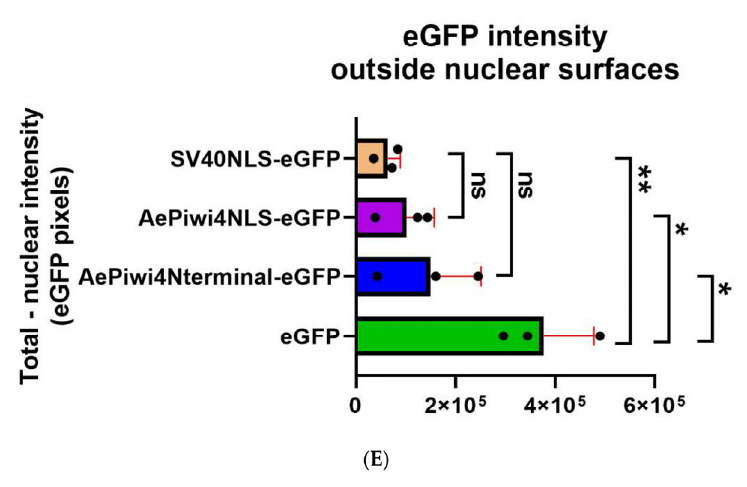
Figure 6. AePiwi4 harbors an NLS in the N-terminal region of the protein. Representative slices from image stacks of HEK293 cells transfected with ( A ) SV40NLS-eGFP, ( B ) eGFP, ( C ) AePiwi4NLS- eGFP, or ( D ) AePiwi4Nterminal-eGFP. Cells were stained with DAPI (blue) 24 h post-transfection. DAPI (left), eGFP (middle), and merged (right) channels are shown separately. Orthogonal views presented in merged channel. Scale bar = 15 μ M. ( E ) Quantification of total eGFP fluorescence in- tensity sums subtracted from eGFP intensity sums in nuclear surfaces for each sample type, normal- ized by number of cells. Each black dot represents an individual picture. Red bars indicate SEM. ** = p ≤ 0.01, * = p ≤ 0.05, ns = non-significant.